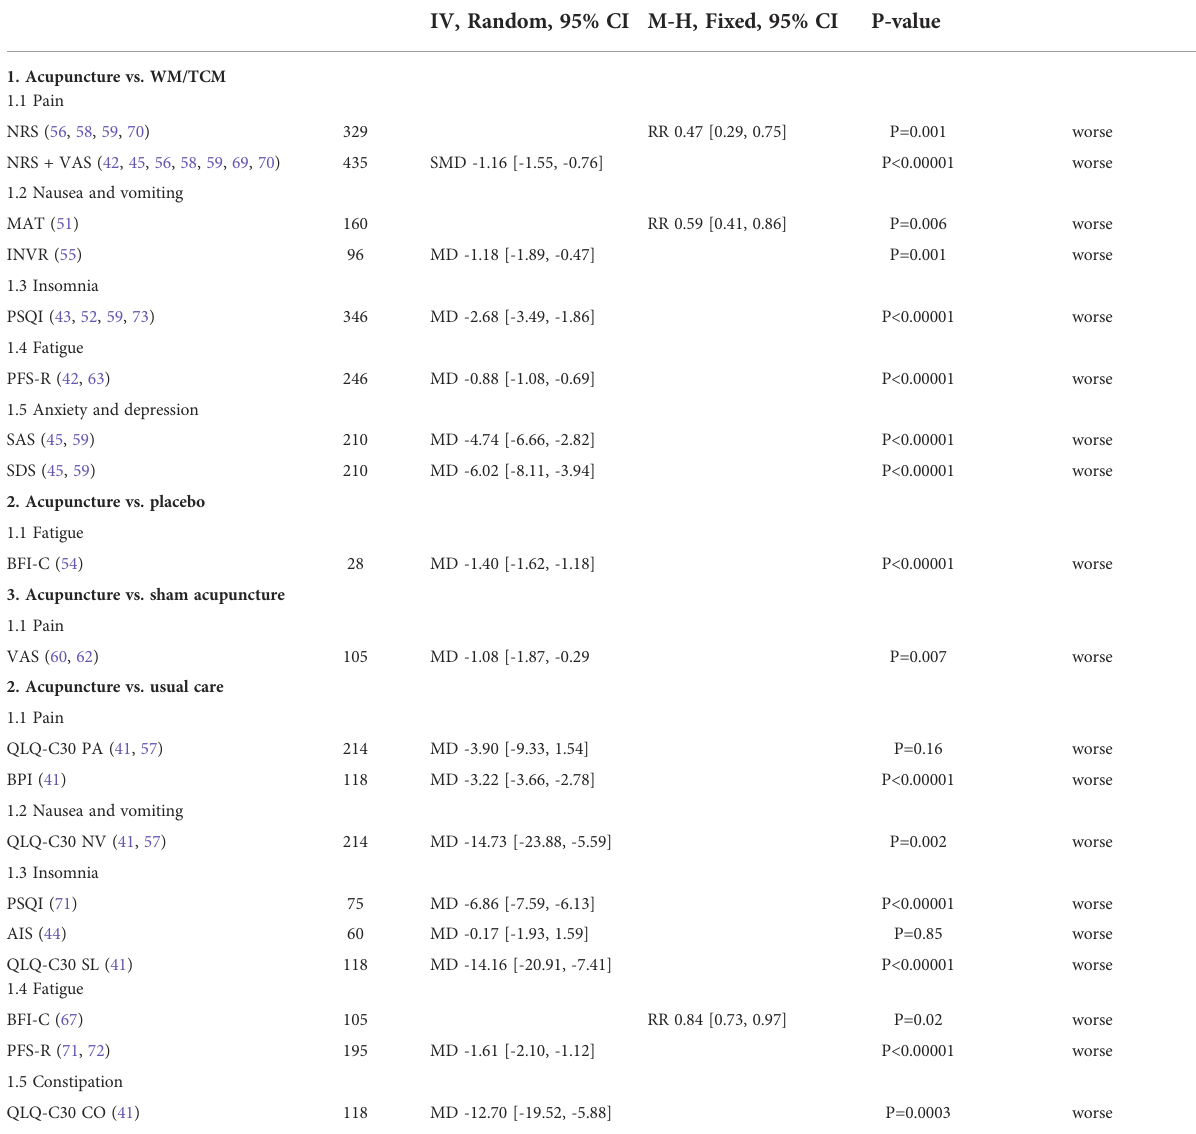
TABLE 5 The effect of acupuncture on the secondary outcomes compared to different